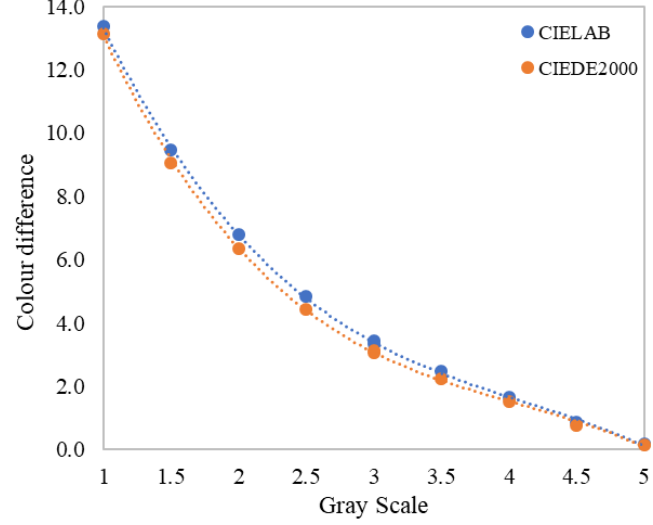
Figure 4. Relationship between the grade values in the 9 color pairs of the SDC gray scale for change in color and their measured color differences in CIELAB and CIEDE2000 units.